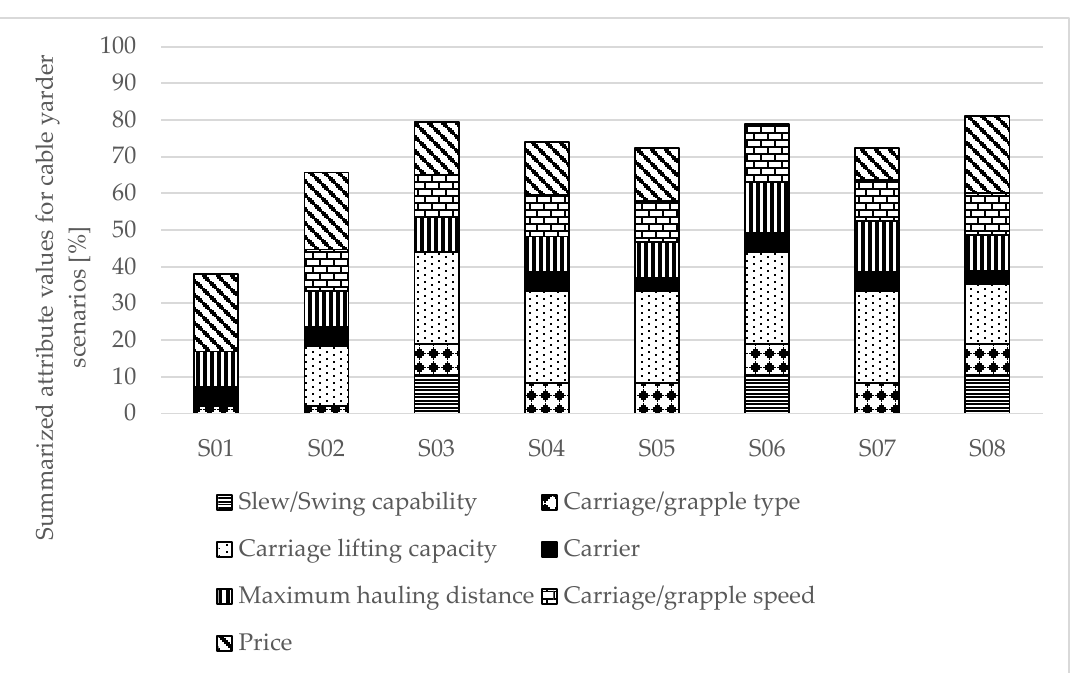
Figure 1. Evaluation of cable yarder scenarios by summarizing attribute values.